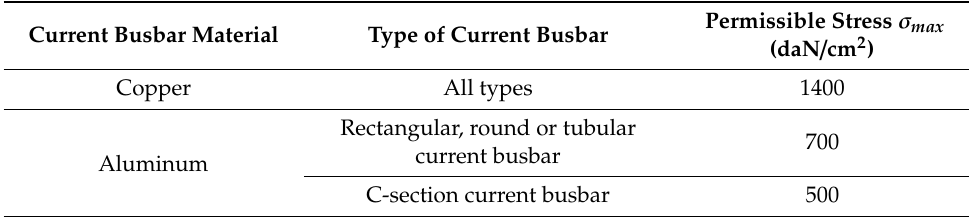
Table 2. Permissible mechanical stress values for busbars with specific shapes made of copper and aluminum.